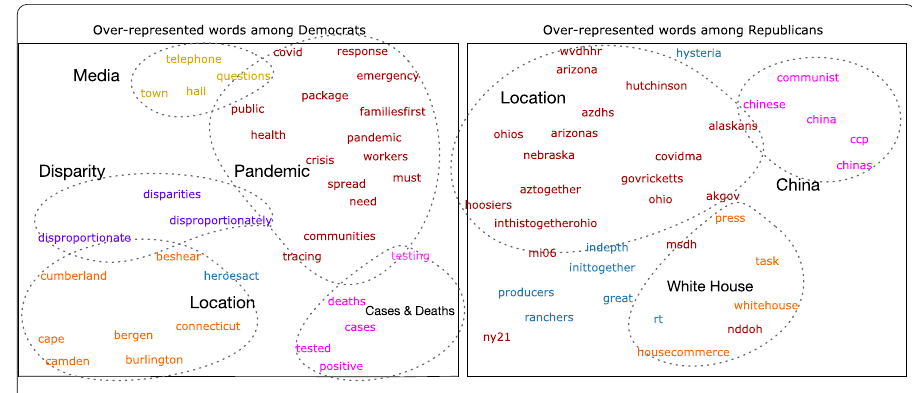
Figure 2 Characteristic words in each party’s tweets related to COVID-19 in the GloVe word embedding space. We detect over-represented words by calculating the log odds ratio of each word (see Sect. 2) and obtain the GloVe embeddings for each word. We use UMAP to reduce dimensionality and plot each word. Colors indicate topic labels that we assign. The Democratic party member’s tweets features more words about the pandemic and its disproportionate influences, while the Republican tweets features words about Trump and the White House as well as words about China